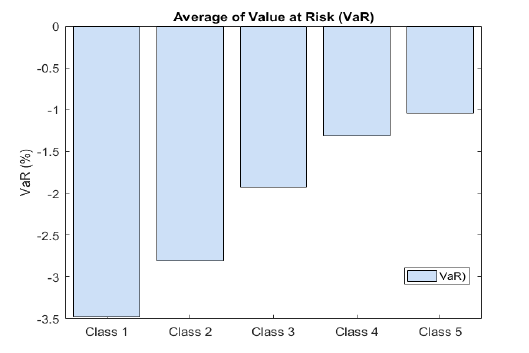
Figure 9. The Bar Chart of Value at Risk Mean in Five Different